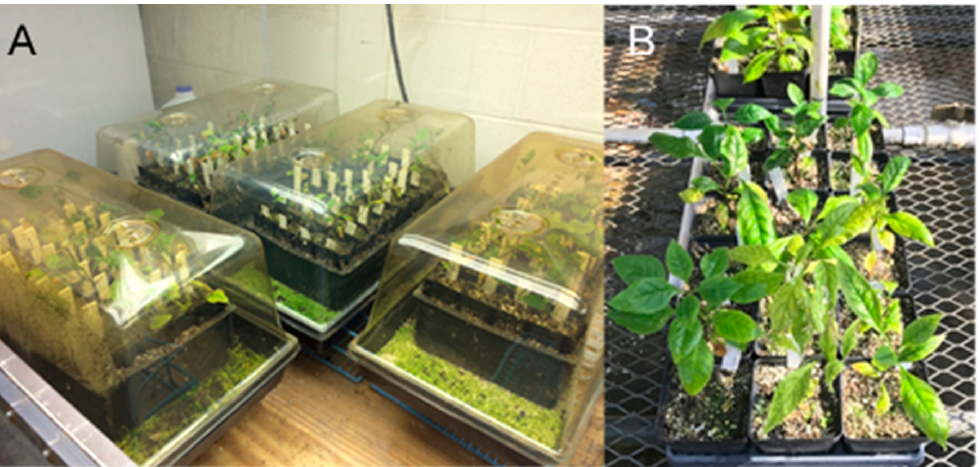
Figure 4. PCR results for presence of GUSi gene in tissues derived from two independent transgenic events for each of the two white ash genotypes (LA112-10, LA115-5) and three green ash genotypes (5-FP-1, 5-FP-2, 5-FP-4). DNA of transgenic and wildtype control somatic seedlings was extracted from leaf tissue, except for DNA of wildtype 5-FP-2, which was extracted from embryogenic tissue. Lanes are as follows: (M) 100 bp molecular weight ladder, (W) no DNA control, (P) GUSi plasmid, (1) LA112-10 wildtype, (2) LA112-10-8 GUSi, (3) LA112-10-9 GUSi; (4) LA115-5 wildtype, (5) LA115- 5-1 GUSi, (6) LA115-5-3 GUSi, (7) 5-FP-1 wildtype, (8) 5-FP-1-1 GUSi, (9) 5-FP-1-3 GUSi, (10) 5-FP-2 wildtype, (11) 5-FP-2-4 GUSi, (12) 5-FP-2-5 GUSi, (13) 5-FP-4 wildtype, (14) 5-FP-4-2 GUSi, (15) 5- FP-4-5 GUSi, and (M) 100 bp molecular weight ladder.